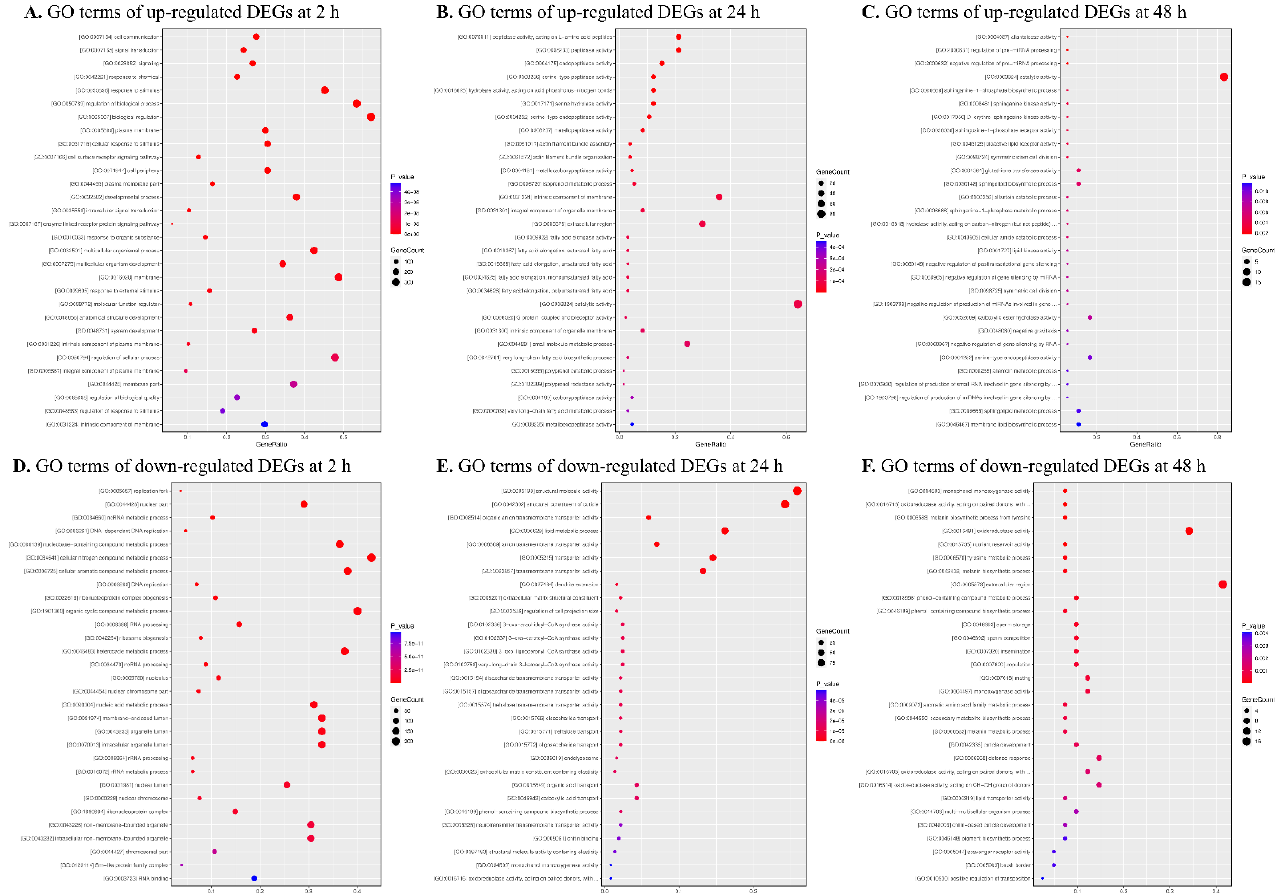
Figure 3. GO functional categories of DEGs obtained from the comparisons of P2 ( A ) vs. NP2 ( D ), P24 ( B ) vs. NP24 ( E ), and P48 ( C ) vs. NP48 ( F ) groups. The rich factor represents the ratio of DEGs in a certain GO category. The size and color of the dots, respectively, indicate the range of gene count and p -value mapped to the corresponding terms.